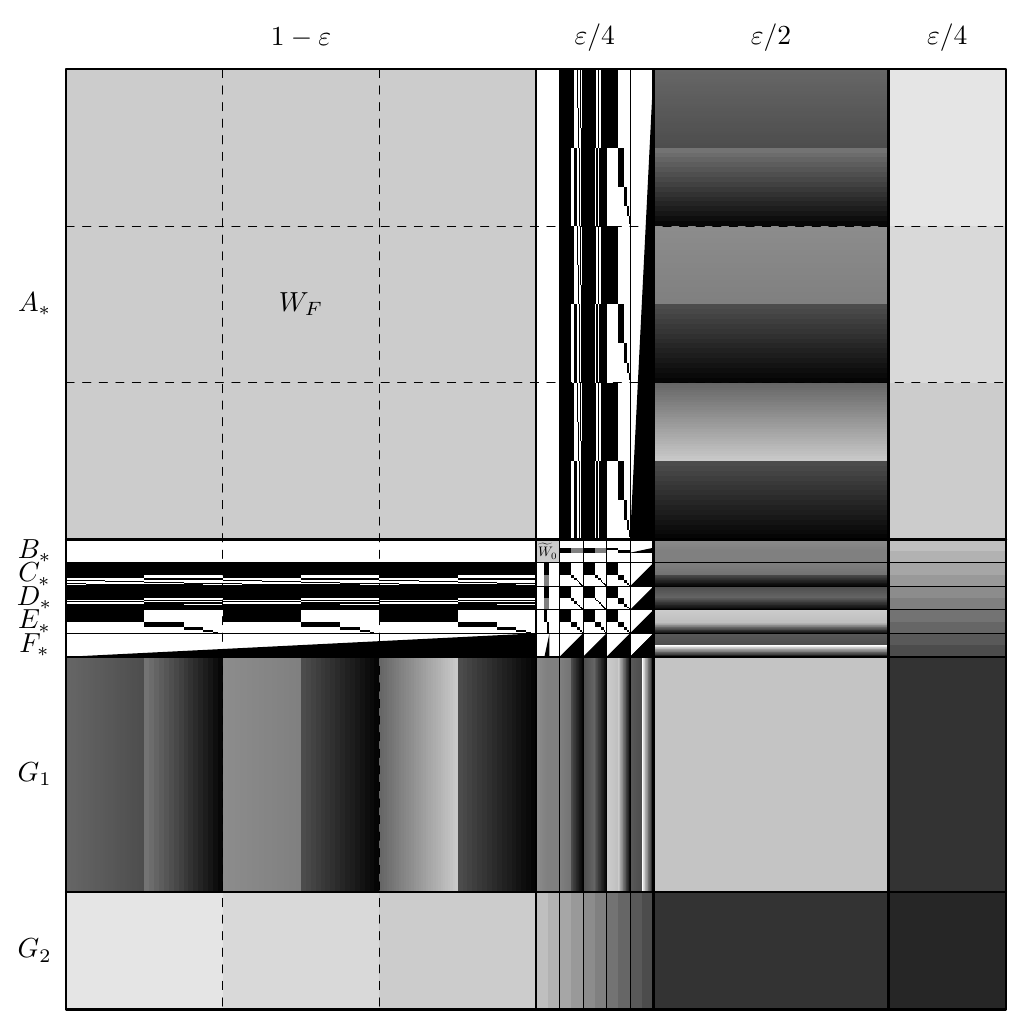
Figure 3: A sketch of the graphon W 0 . The composite tile A ∗ × A ∗ contains the graphon W F and the composite tile B ∗ × B ∗ contains the graphon (cid:101) W 0 from Theorem 12. An enhanced sketch of the structure between the parts contained in A ∗ and B G ∗ and the parts contained in C ∗ , D ∗ , E ∗ and F ∗ is given in Figure 4.